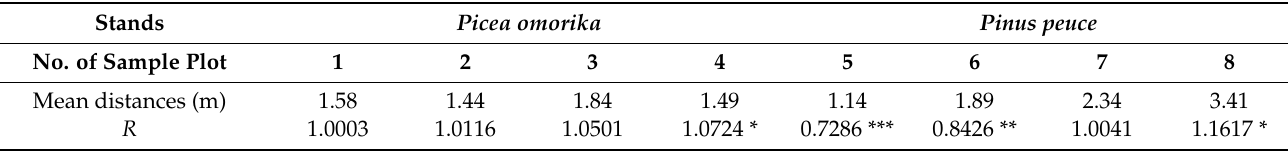
Table 3. Basic spatial characteristics. Mean distance between individuals (m) and aggregation index ( R